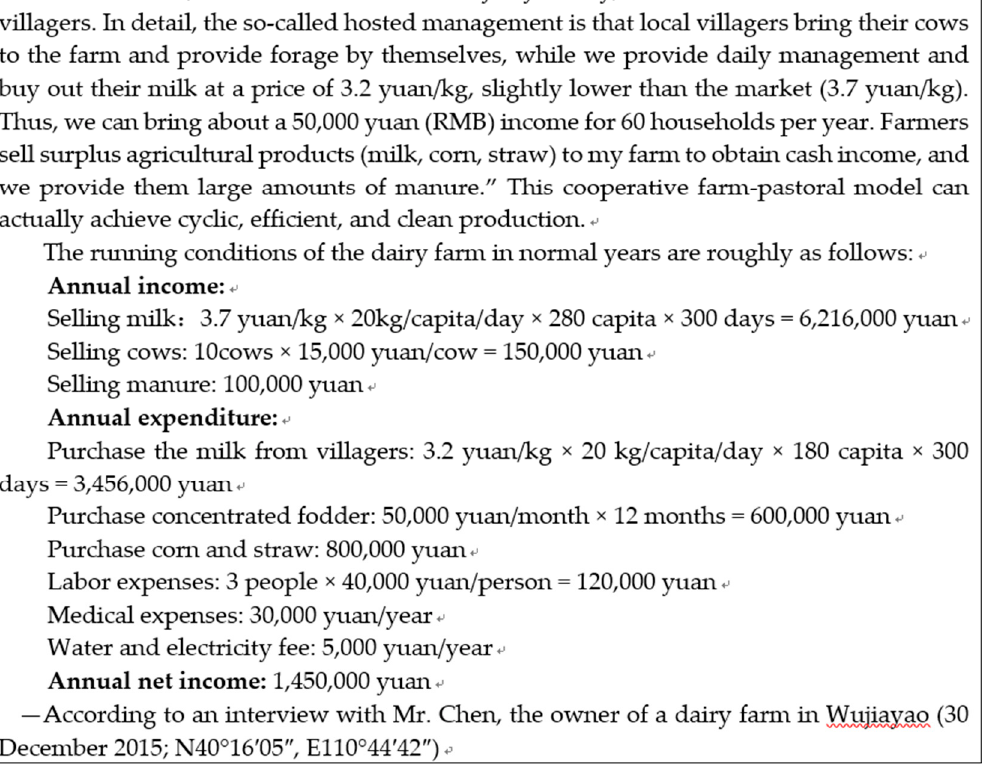
Figure 5. Interview with a farmer in Wujiayao village.4.2.2. Livelihoods in Gongyigai Village